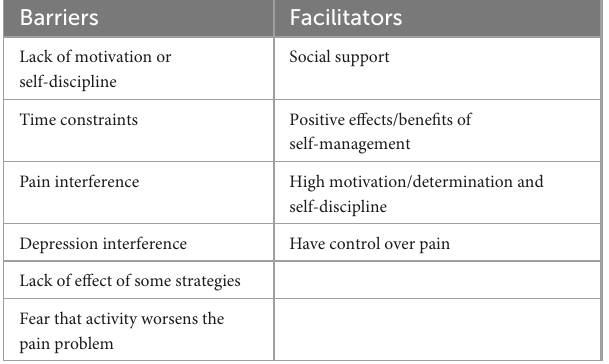
TABLE 5 Barriers and facilitators to use pain self-management